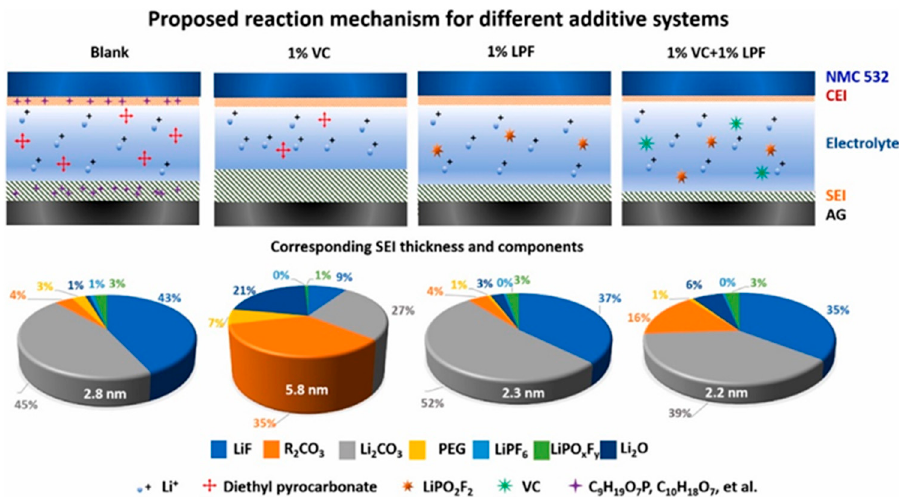
Figure 3. Proposed reaction mechanism of different additives on the passivating layers of NMC523/graphite cells and the specific atomic ratio of the SEI components on the anode. Reprinted from [163], with permission from Elsevier.